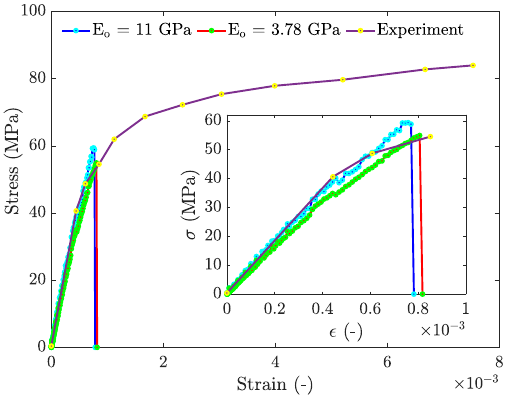
Figure 4. Comparison of FE simulation results with experimental result [11] of 5% organic matrix for two different values of elastic modulus: E o = 3.78 GPa and E o = 11 GPa of organic matrix. Inset: Enlarged view of the stress-strain curves. Excellent agreement can be observed between the simulations and the experiment in the elastic region.